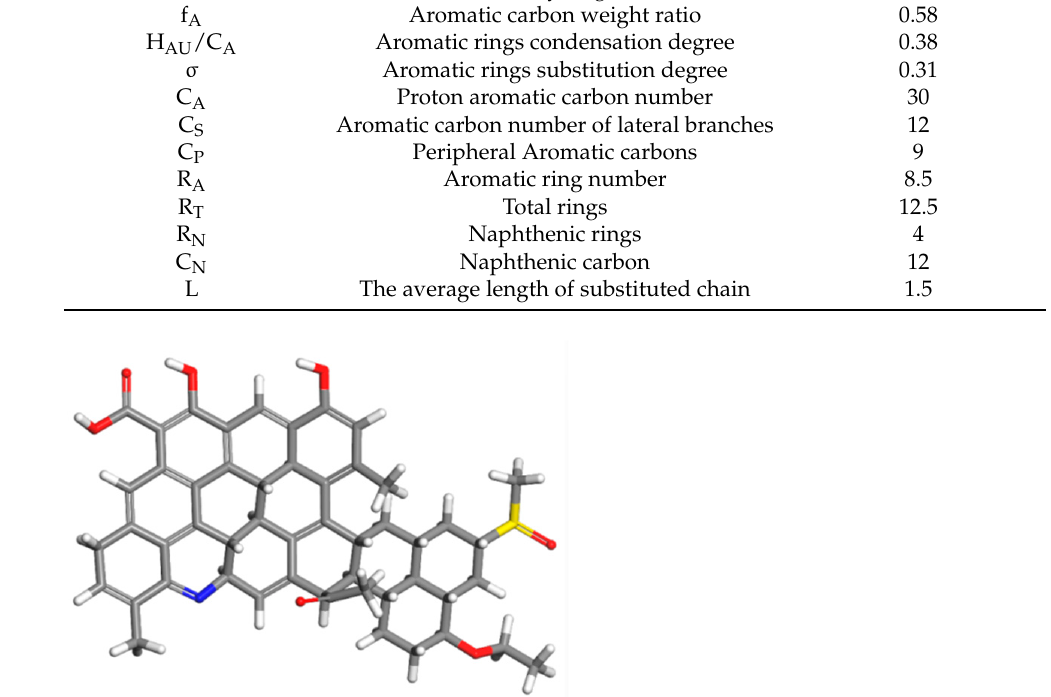
Figure 5. The average structure of asphaltene derived from marine very-low-sulfur fuel oil (carbon: grey, hydrogen: white, oxygen: red, sulfur: yellow, nitrogen: blue).